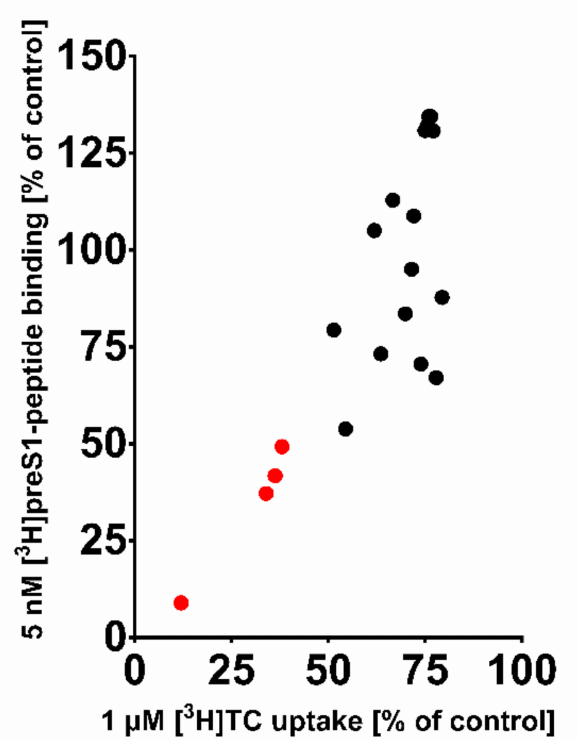
Figure 6. Residual [ 3 H]TC transport activity via NTCP vs. residual [ 3 H]preS1-peptide binding to NTCP in the presence of the top-20-hit compounds from the virtual QSAR screen. All compounds were used at 100 µ M inhibitor concentrations in transport assays with 1 µ M [ 3 H]TC and binding assays with 5 nM [ 3 H]preS1-peptide, both in NTCP-HEK293 cells for 10 min at 37 ◦ C. Compounds resulting in less than 50% residual [ 3 H]preS1-peptide binding compared to solvent control are highlighted in red. For these compounds IC 50 values were determined as indicated in Figure